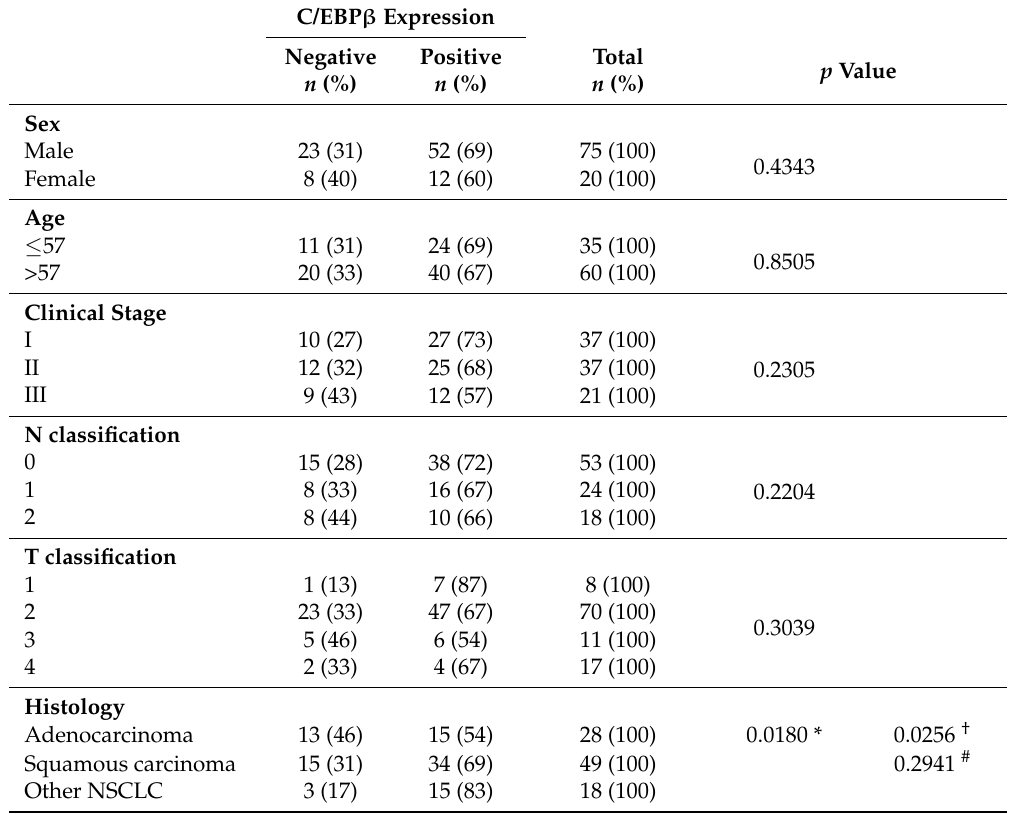
Table 2. Summary of C/EBP β expression and clinicopathological feature in the lung cancer